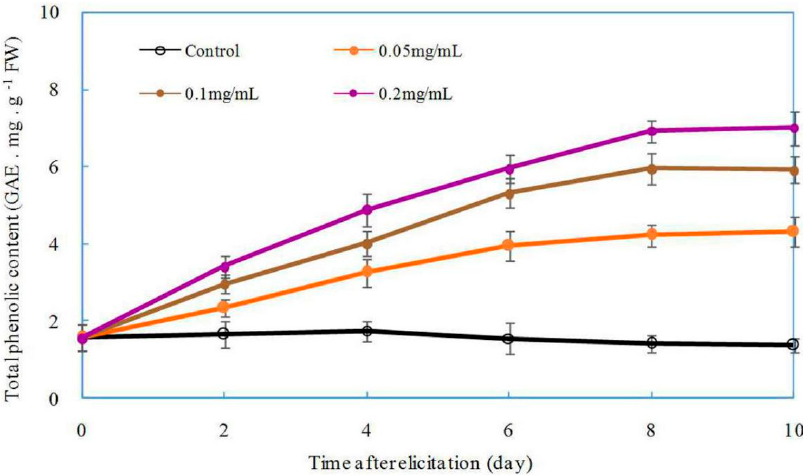
Figure 8. Effect of oligochitosan DP5 on the accumulation of total phenolics in Zanthoxylum bungeanum . Error bars represent standard deviations of the means from three independent samples. FW means fresh weight of plant material. GAE means Gallic acid equivalent.